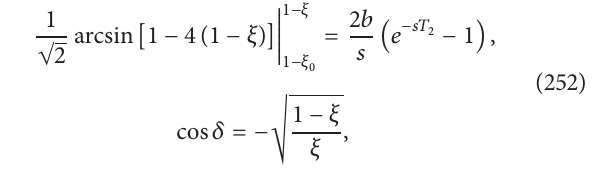
Figure 7: Phase portrait for the case of 1:1 internal resonance 𝜔 1 = 𝐾 = 𝐾 = 0 𝜔 3 at 2 3